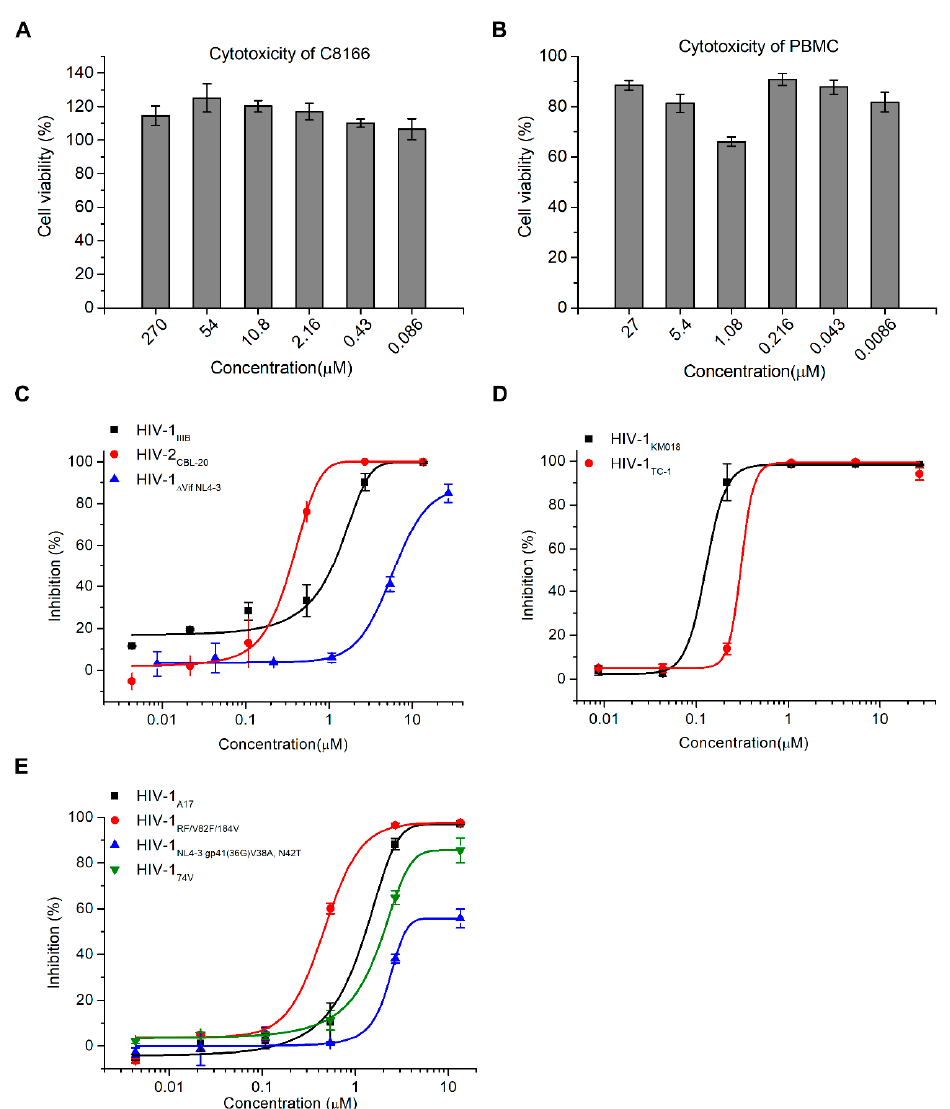
Figure 2. Hop-8 inhibited HIV-1 and HIV-2 wild-type, clinical isolates and resistant strains with low cytotoxicity. ( A ) The cytotoxicity of hop-8 in C8166; ( B ) The cytotoxicity of hop-8 in peripheral blood mononuclear cells (PBMCs); ( C ) The antiviral activities of hop-8 against the clinical isolates HIV-1 KM018 , and HIV-1 TC-1 were measured in PBMCs; ( D ) The antiviral activities of hop-8 against wild-type HIV-1 IIIB , HIV-2 CBL-20 , and HIV-1 ∆ Vif NL4-3 were measured in the C8166 cell line; ( E ) Antiviral activities of hop-8 against the HIV-1 drug resistant strains HIV-1 A17 , HIV-1 NL4-3 gp41 (36G) V38A, N42T , HIV-1 RF/V28F/184V , and HIV-1 74V . The levels of p24 in the cell culture supernatant were measured by ELISA. Each data point represents the mean percent inhibition (relative to the positive control) ± standard deviation (bars), n ≥ 2. Data were analyzed with Origin 8.5 (OriginLab, MA, USA).